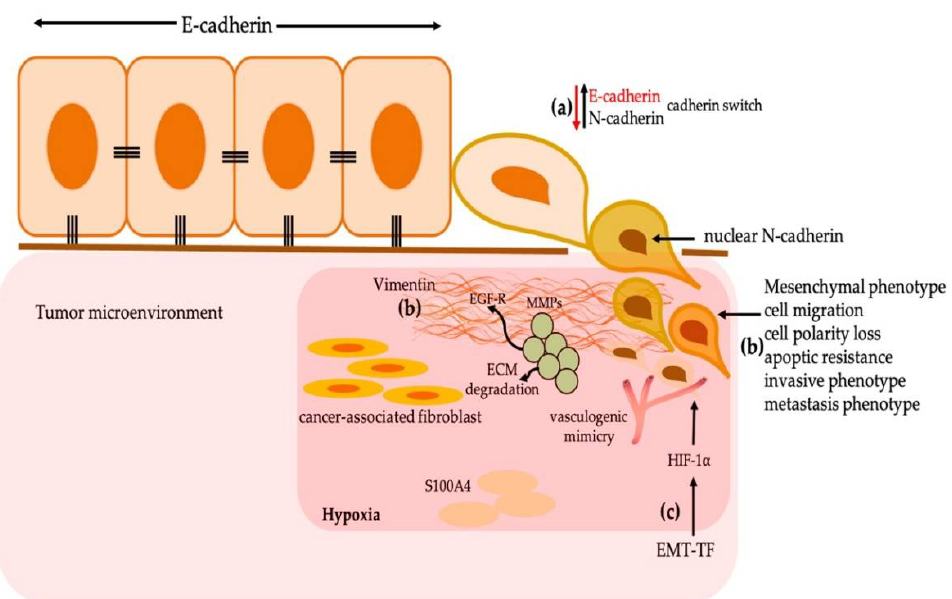
Figure 2. ( a ) Cadherin switch: this phenomenon is related to the gain of mesenchymal cadherins (N-cadherin) and loss of E-cadherin, which are related to the loss of cell adhesion. ( b ) The over- regulation of Vimentin and N-cadherin are related to the loss of E-cadherin, induction of EMT, cell migration, loss of cell polarity, resistance to apoptosis, and invasive and metastatic phenotypes. ( c ) Tumoral hypoxia (HIF1- α ) in the induction of EMT through epithelial–mesenchymal transition. This interaction induces vasculogenic mimicry, increases cell plasticity, promotes metastasis, and is capable of interacting with matrix metalloproteinases (MMPs), related to the degradation of E- cadherin through epidermal growth factor receptor (EGF-R), an increase in EMT-TF, the promotion of cell invasion, degradation of the extracellular matrix (ECM), tumor recurrence, metastasis, and the development of secondary primary